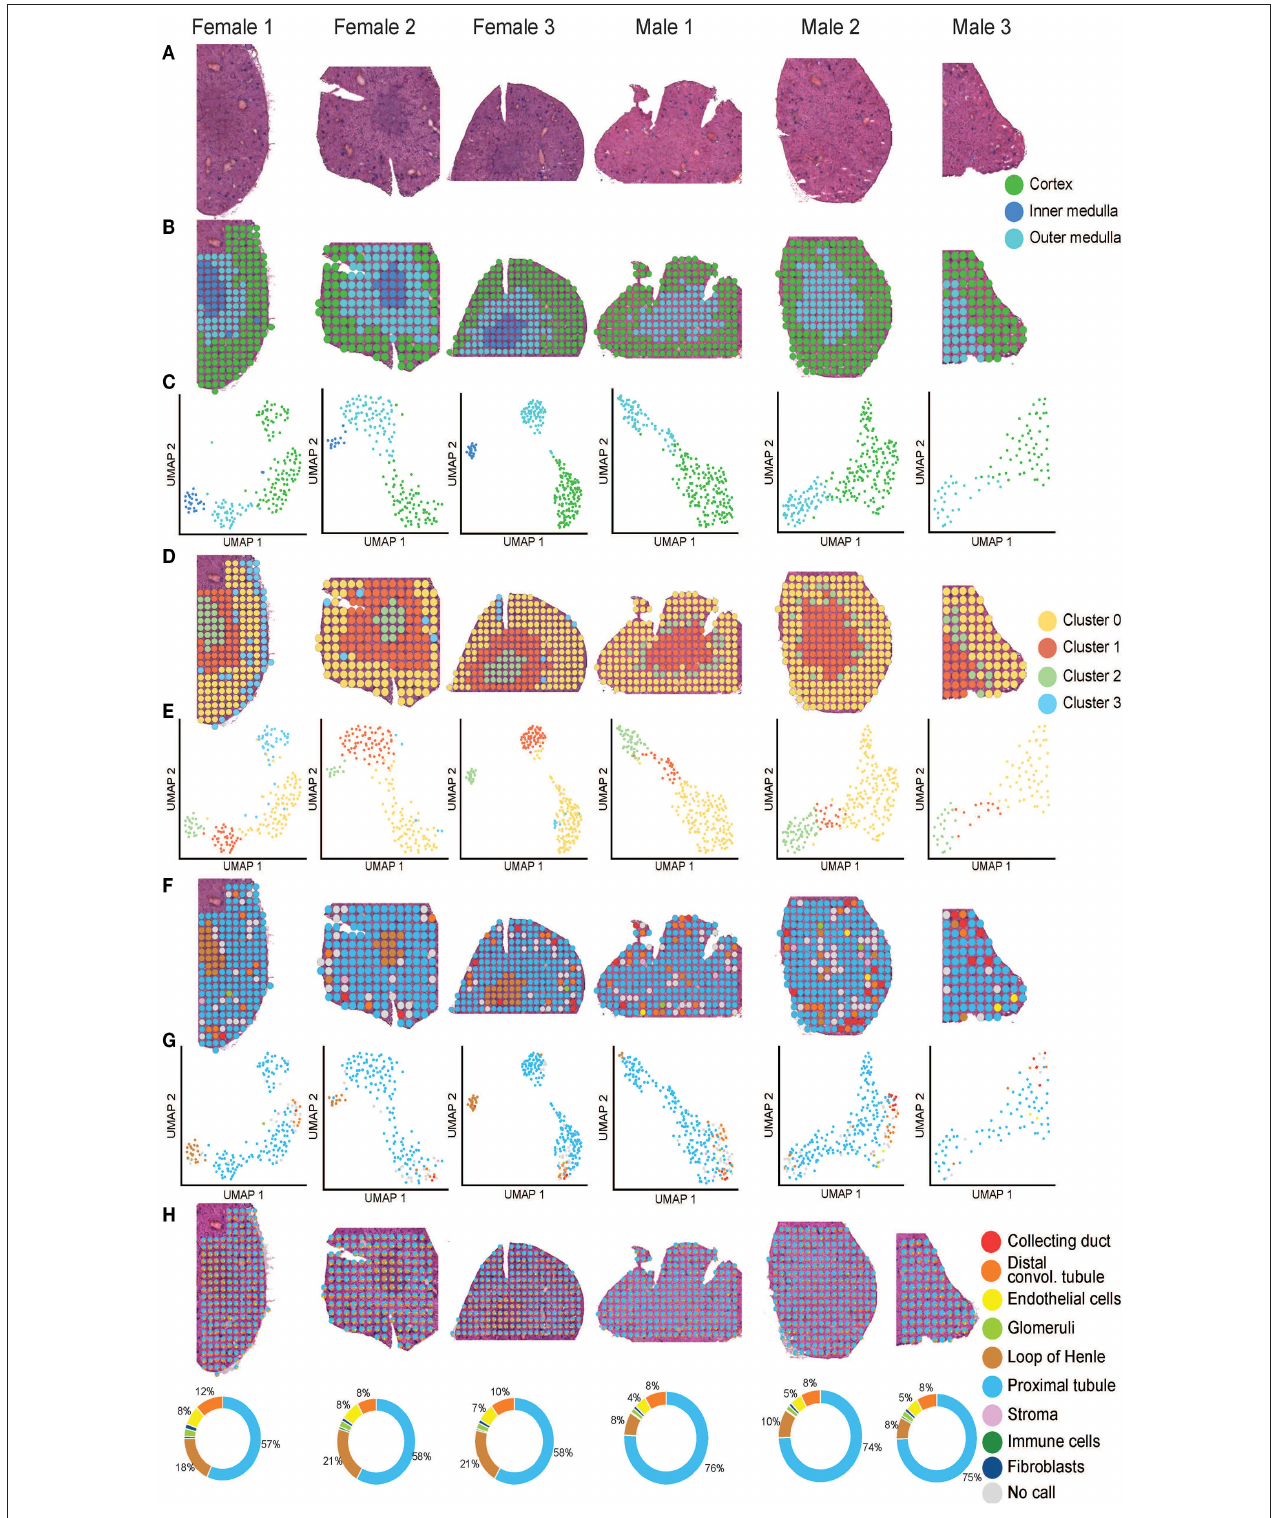
FIGURE 2 | Mouse ST-seq consensus labels. (A) H&E images of the mouse kidney tissues from three females and three males. (B, C) The functional cortical and medullary regions, which were annotated within the mouse ST-seq datasets by a Consultant Pathologist were mapped to the H&E tissue sections and presented in the UMAP. (D, E) The spatial organization of the KNN clusters was mapped to the H&E tissue images and presented in a UMAP. (F,G) The spatial organization of the consensus-based label transfer results was mapped to the H&E tissue images and presented in a UMAP, respectively. (H) The spatial organization of the deconvoluted functional structures was mapped to the H&E tissue images and presented as simple pie charts to demonstrate the proportions.